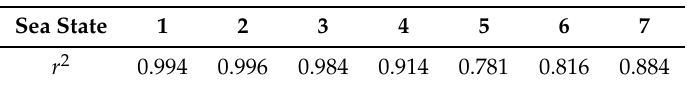
Table 5. Time series simulation from reflection analysis vs. measured time series. Mean coefficient of determination, r 2 , shown for each test. Averaged over all gauges and all repeats. Sea state references refer to those defined in Table